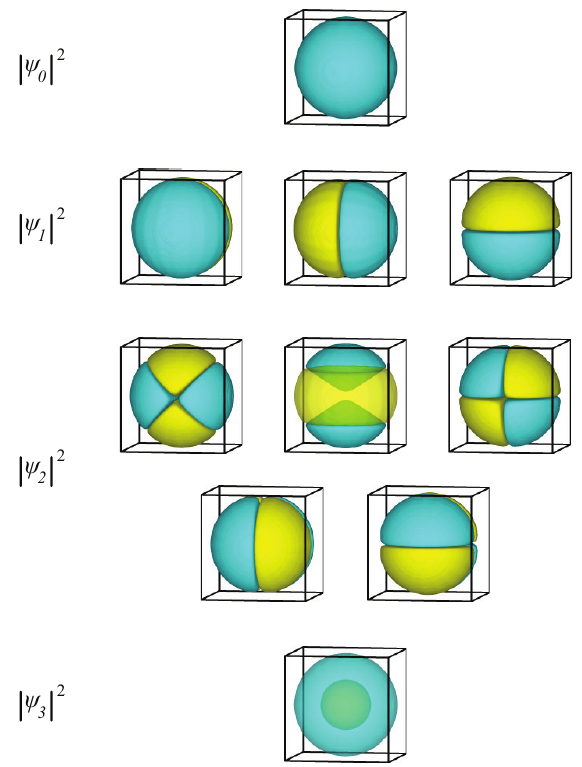
Figure 1. The probability function, | ψ | 2 , of the first ten eigenstates of an electron inside a sphere. Yellow represents positive and cyan represents negative values of the wavefunction.